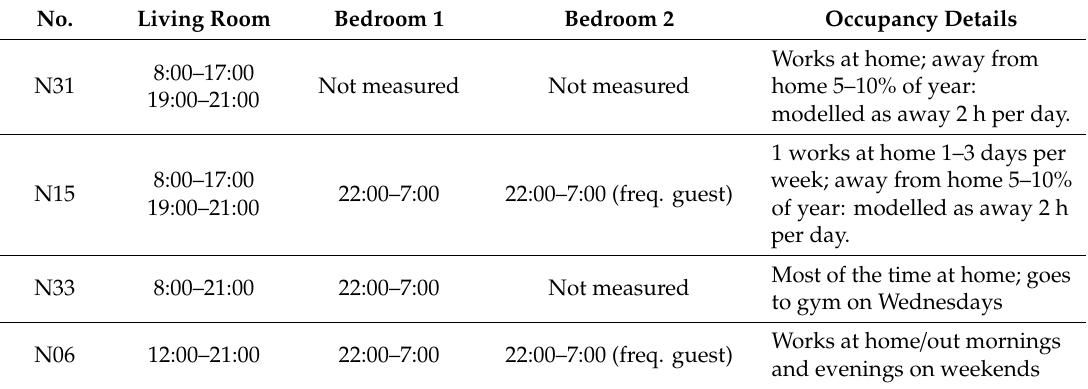
Table 4. Case study occupancy